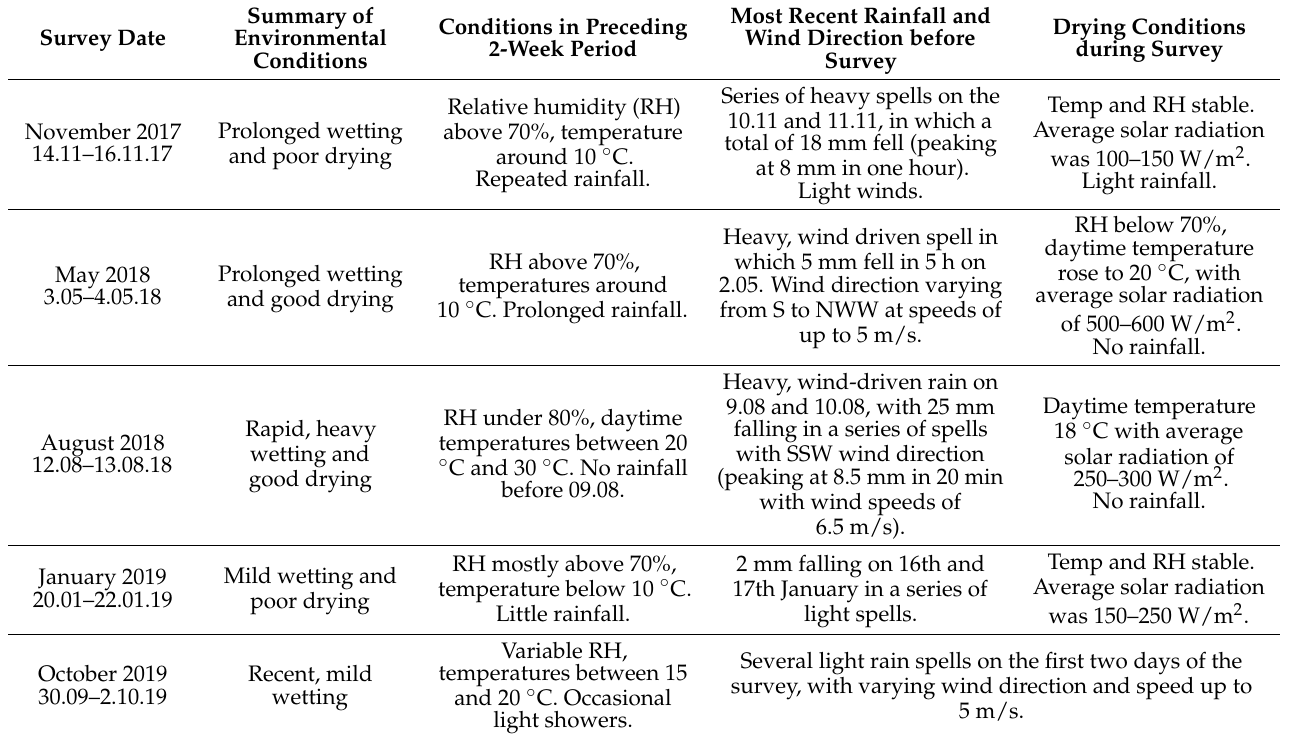
Table 1. Summary of field survey dates showing wetting and drying